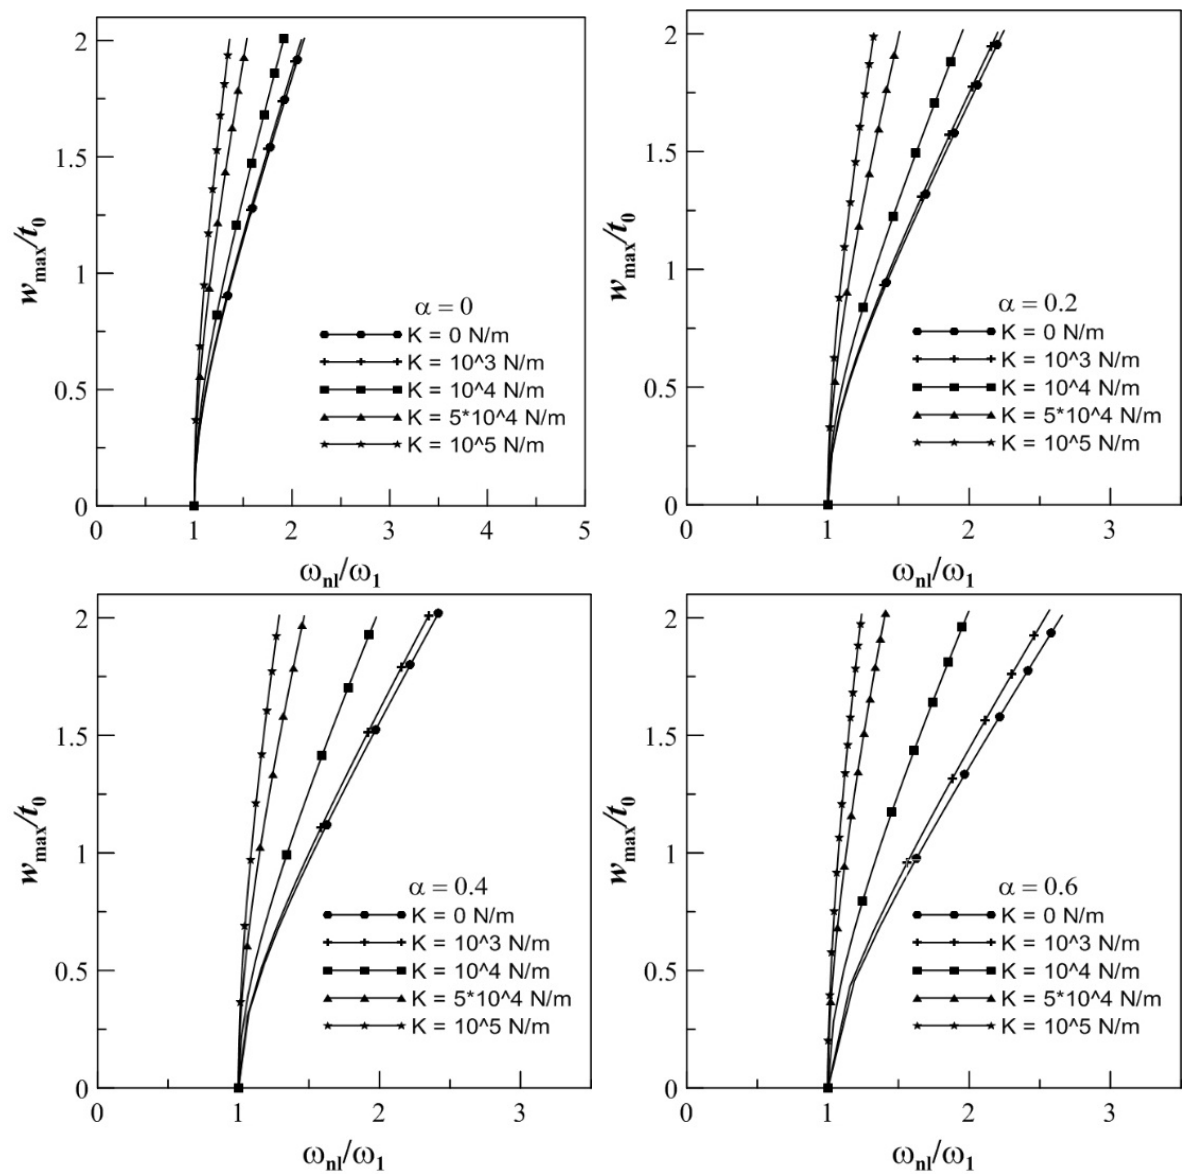
Figure 4: Backbone curve of AFG linear taper beam (︀ E ( ξ ) = E 0 (1 + ξ ) , ρ ( ξ ) = ρ 0 (︀ 1 + ξ + ξ 2 )︀)︀ on elastic foundation.